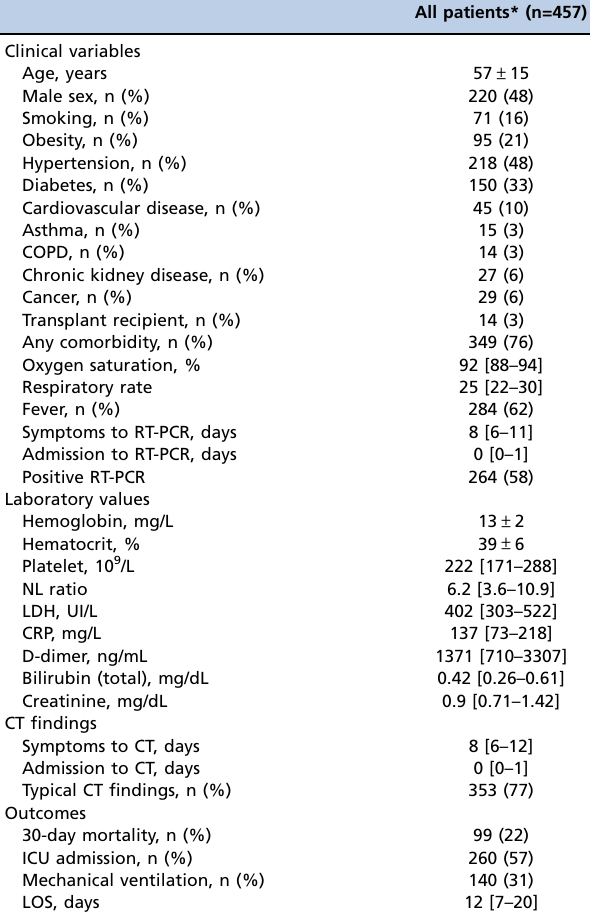
Table 1 - Baseline characteristics and outcomes of admitted patients.